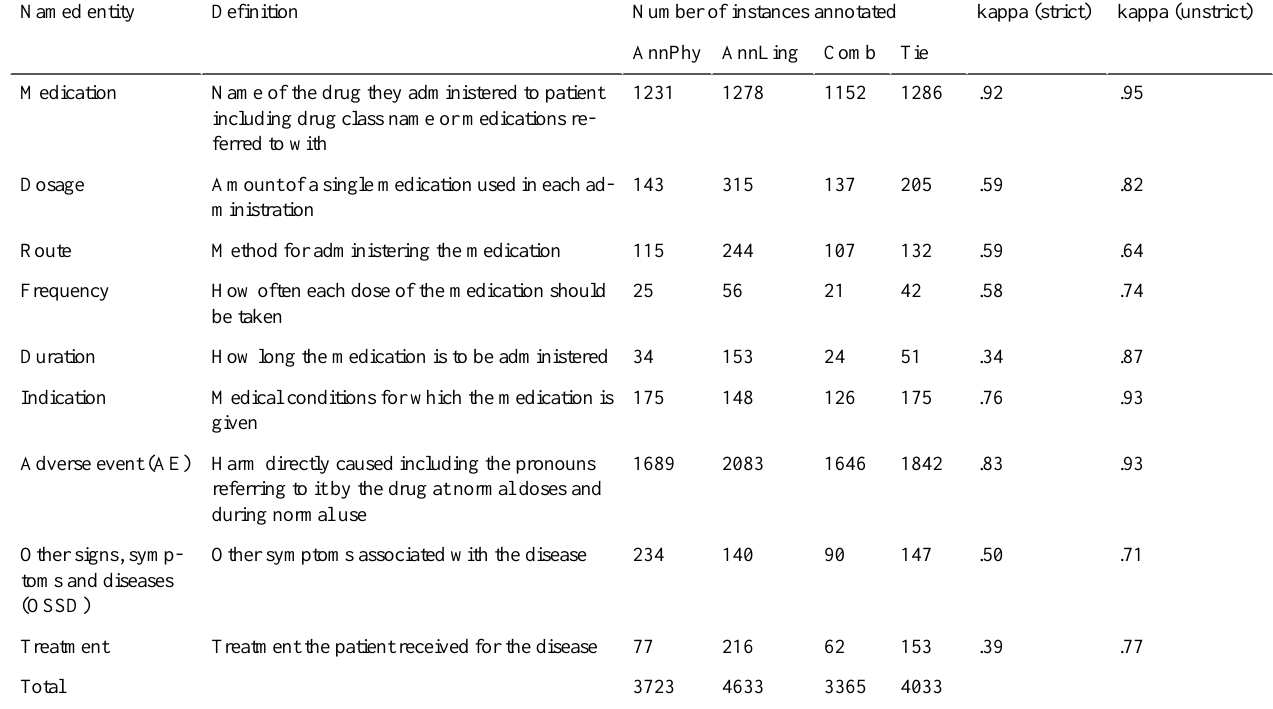
Table 1. Named entity definition, number of annotated instances, and inter-annotator agreement measured by Cohen’s kappa for both strict and unstrict